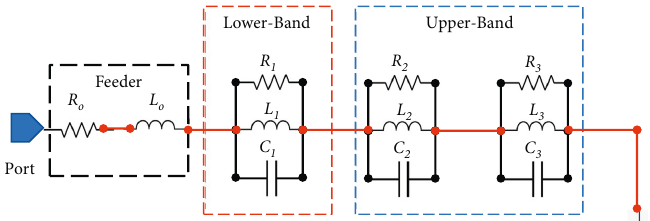
Figure 10: Proposed OBS antenna